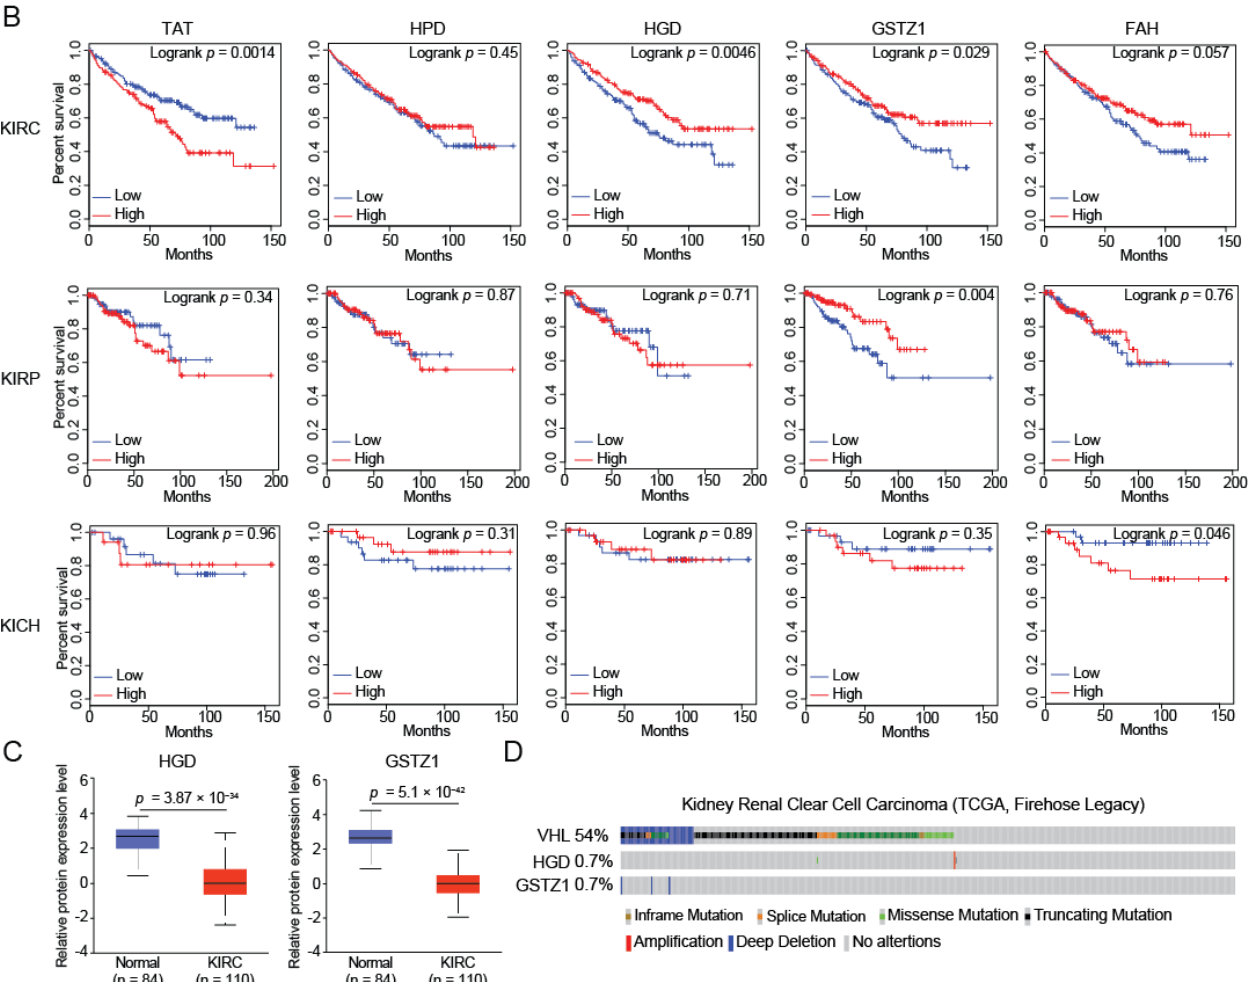
Figure 1. HGD and GSTZ1 are down-regulated and associated with prognosis in KIRC. ( A ) The tyrosine-metabolizing enzymes (TAT, HPD, HGD, GSTZ1, and FAH) mRNA expression levels be- tween tumor and normal tissues in patients with RCC in TGCA database. ( B ) Overall survival of patients with RCC grouped by tyrosine-metabolizing enzymes’ expression through GEPIA web server. ( C ) The tyrosine-metabolizing enzymes (HGD and GSTZ1) protein expression levels between tumor and normal tissues in patients with KIRC in TGCA database. ( D ) The types and frequency of mutations of VHL, HGD and GSTZ1 in RCC patients.